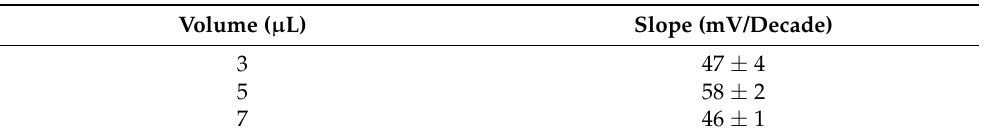
Figure 4. SEM morphologies of ( a ) bare GSPE and ( b ) (Au&Ag)NPs-modified GSPE. ( c ) EDX spectrum of (Au&Ag)NPs/GSPE. Table 3. Linear regressions obtained for lithium detection using sensors covered with different volumes of the ion-selective membrane cocktail (n =